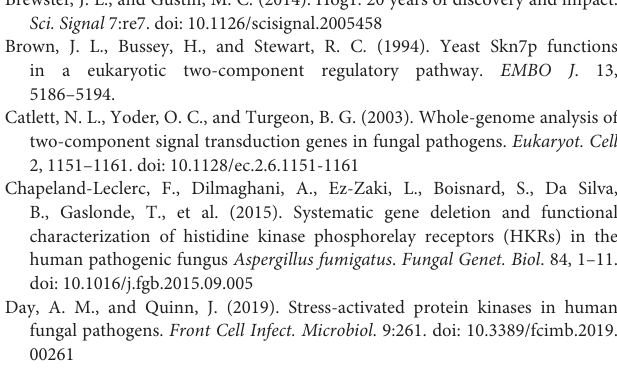
confocal stacks. Supplementary Figure 3 | Growth and fludioxonil sensitivity of the AfS35 ypd 1 tet − on strain in the presence of different doxy concentrations. Both panels show 6 well tissue culture plates that contained AMM agar supplemented with the indicated concentrations of doxy (in µ g/ml). The agar in the lower plate contained 1 µ g/ml of fludioxonil. 5 × 10 4 conidia were applied per spot and the plates were incubated at 37 ◦ C for 48h. The few white colonies that appeared after growth on fludioxonil-containing agar supplemented with 0.5 to 5 µ g/ml doxy are most likely spontaneous mutants. Supplementary Figure 4 | Alignment of the protein sequences of S. cerevisiae Ypd1p (YDL235C), A. fumigatus Ypd1 (Afu4g10280) and A. nidulans YpdA (AN2005). The conserved histidine residue in the HPT domain is indicated in red. The HPT domain itself is underlined. Supplementary Figure 5 | qPCR analysis of ypd 1 expression in AfS35 ypd 1 tet − on and its derivatives expressing either wild type ypd 1 or ypd 1 harboring the H89G point mutation. All strains were grown in AMM supplemented with 0.5 µ g/ml doxy. Supplementary Figure 6 | (A) shows colonies of the indicated mutants that were grown for 48h on AMM plates without doxy. The microscopic images show bright field images (B,D,F) and CFW staining (C,E,G) of hyphae from the edge of these colonies. The arrows in (F) indicate hyphal tips showing an